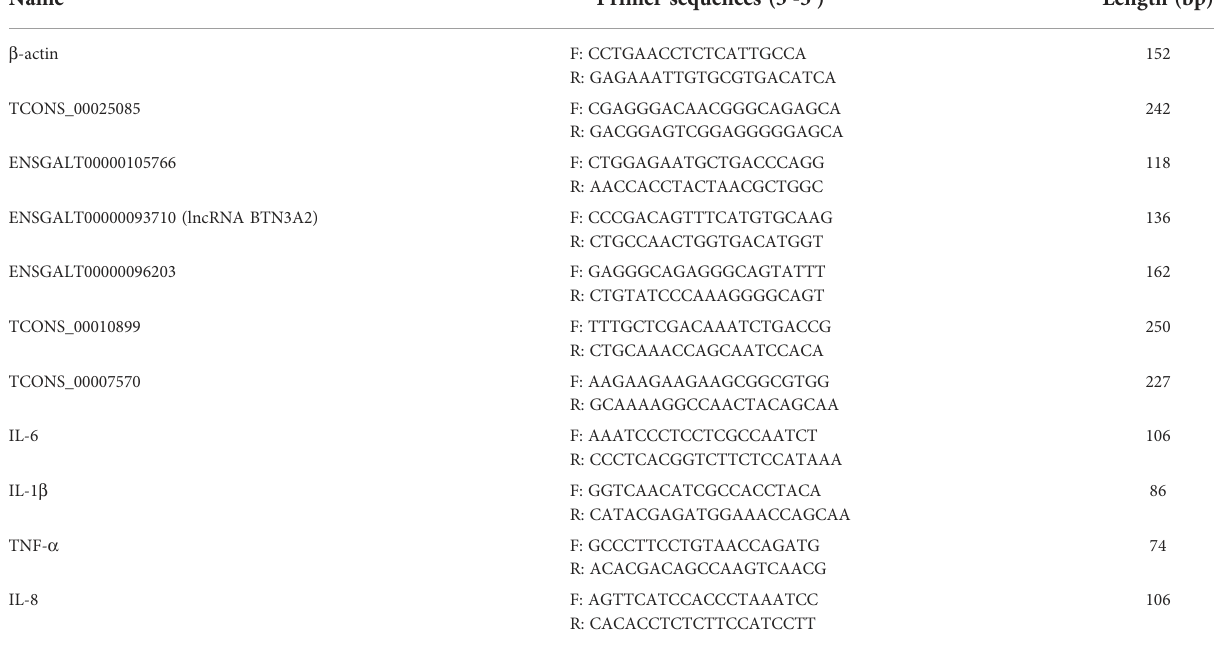
TABLE 2 The primer sequences for differentially expressed lncRNAs and